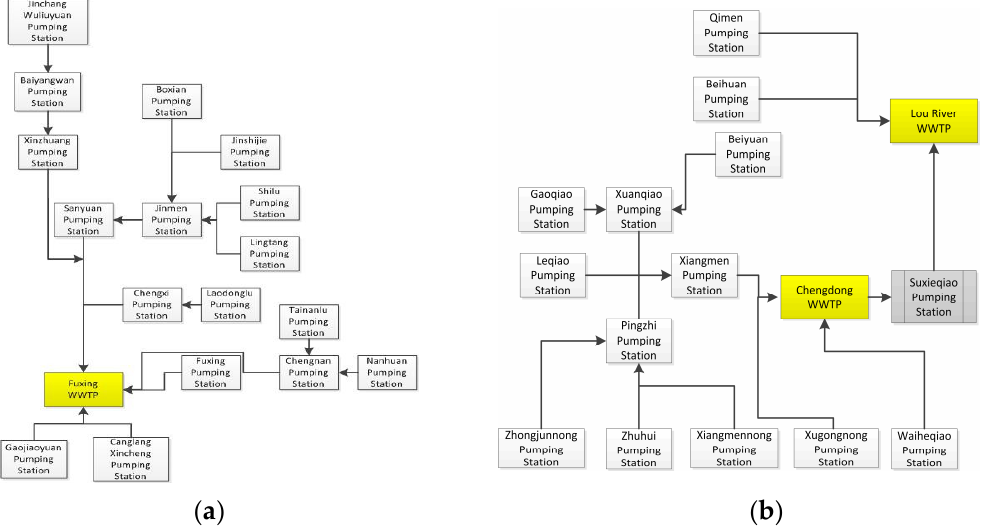
Figure 3. Schematic diagram of the scheduling logic for sewage pumping stations in the study